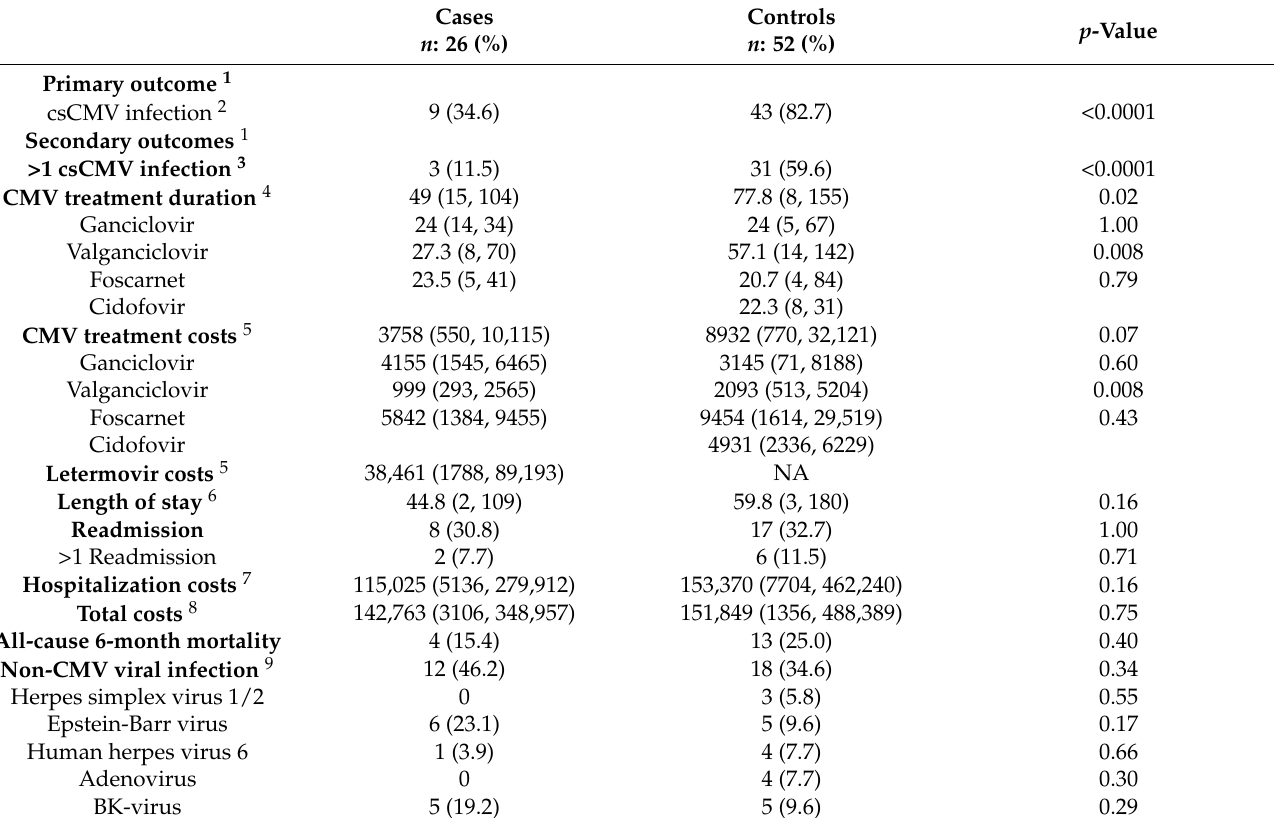
Table 2. Primary and secondary clinical outcomes between cases and controls during the first 180 days post-study inclusion 1